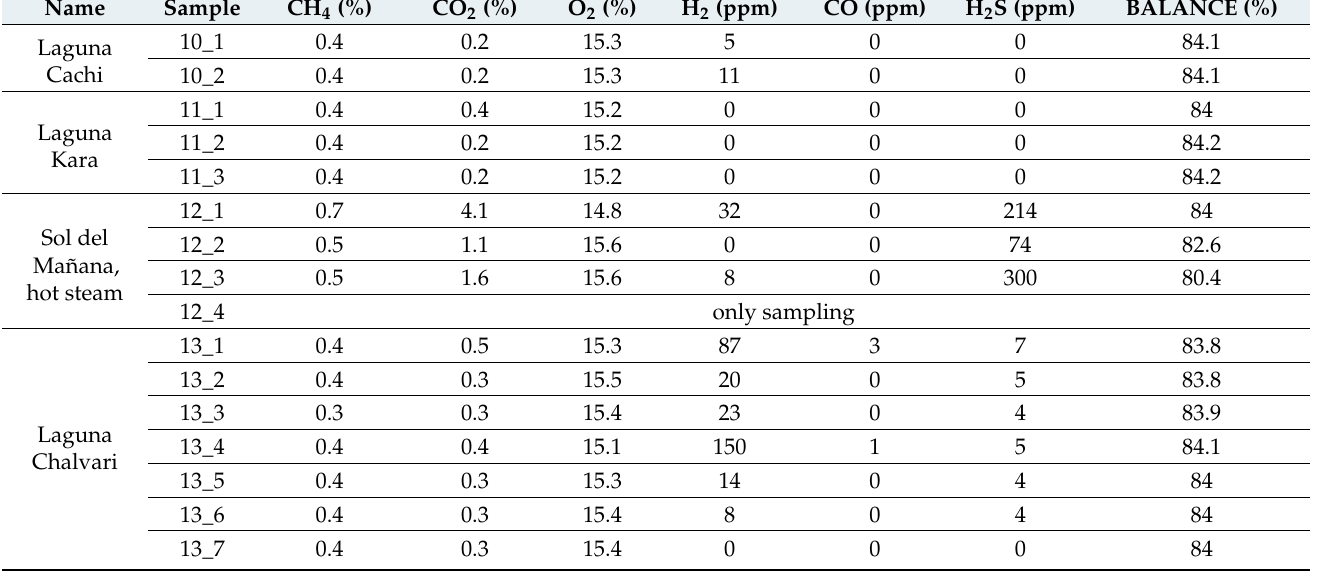
Table 2. Soil gas in situ measurement around the South